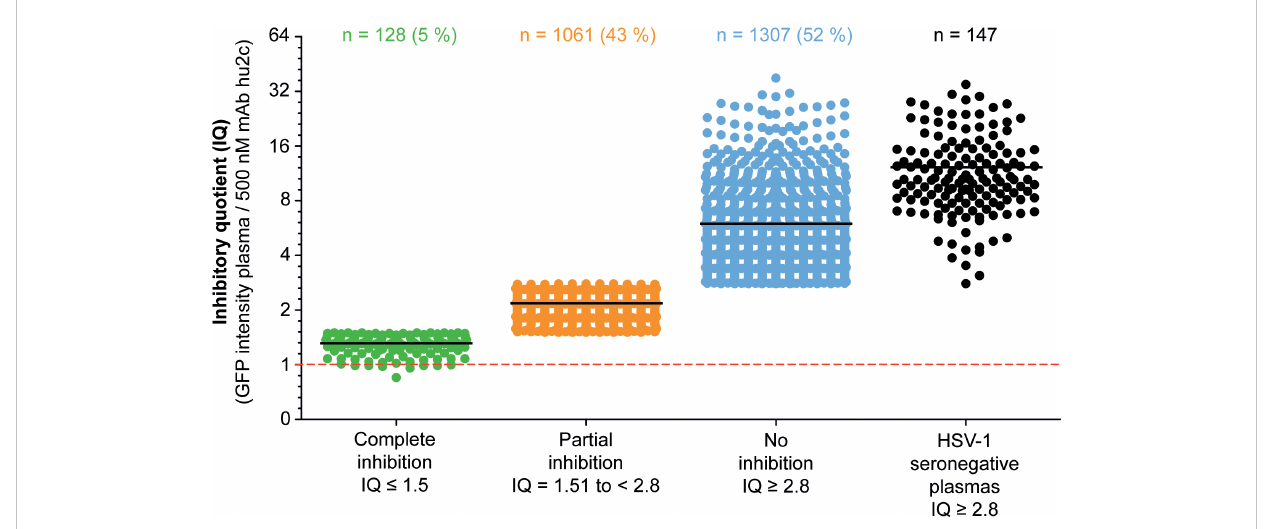
FIGURE 2 Assessment of the HSV-1 cell-to-cell spread inhibition capacity of plasma samples from HSV-1 seropositive blood donor. A total number of 2,496 plasma samples from blood donors were investigated for HSV-1 cell-to-cell spreading properties using a HSV-1 D gE GFP reporter virus-based assay as described above. The ef fi cacy of the plasma samples regarding cell-to-cell spread inhibition is shown as a fold change of the 500 nM mAb hu2c threshold (dashed line). At this concentration mAb hu2c completely inhibits the HSV-1 cell-to-cell spread. The ef fi cacy of the plasma samples regarding cell-to-cell spread inhibition was determined by dividing the GFP-signal of a cell culture treated with a plasma sample through the GFP- signal of mAb hu2c control. This quotient was termed inhibitory quotient (IQ) and represents the x-fold value of the GFP-signal measured for mAb hu2c. The plasma samples were classi fi ed as completely cell-to-cell spread inhibiting (green dots, IQ ≤ 1.5), partially inhibiting (orange dots, IQ = 1.51 - 2.8) and non-inhibiting (blue dots, IQ ≥ 2.8). Each point represents the IQ for each donor; horizontal bars represent the median